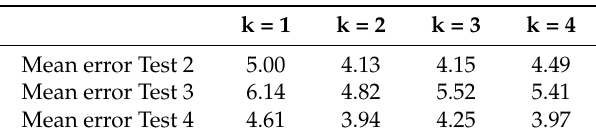
Table 5. Comparison of the accuracy of Test 2, Test 3 and Test 4 for the Wi-Fi_1 database: mean errors for different k